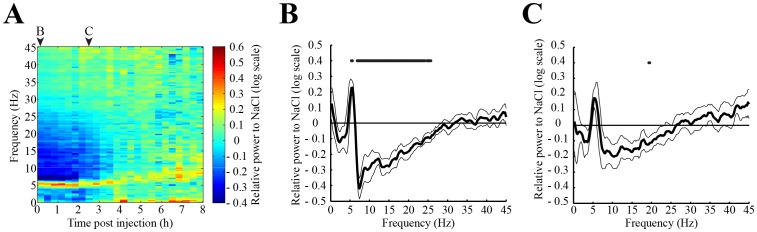
Spectral characterization of the sustained waking state induced by muscimol injection in the DPGi.
A, Group data of time-frequency analysis of EEG signal during the 8 h following muscimol injection in the DPGi. The relative power in each frequency bin after muscimol treatment was normalized to NaCl values and represented using a logarithmic scale. The values of the two 20 min blocks highlighted by letters B and C in panel A are represented in B and C. Values are mean ± SEM, n = 7 in each group. The black points above the graphs show the frequency bins significantly different between the two conditions (p<0.05).